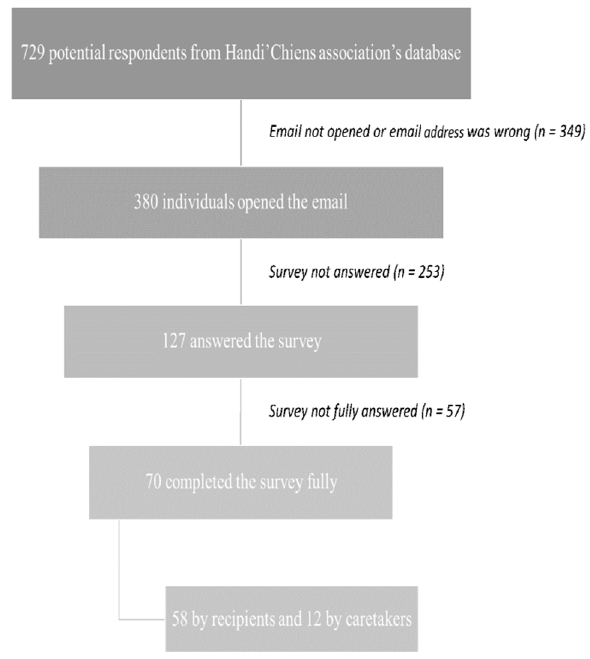
Figure 1. Flow chart showing the survey process and criteria used to include survey’s